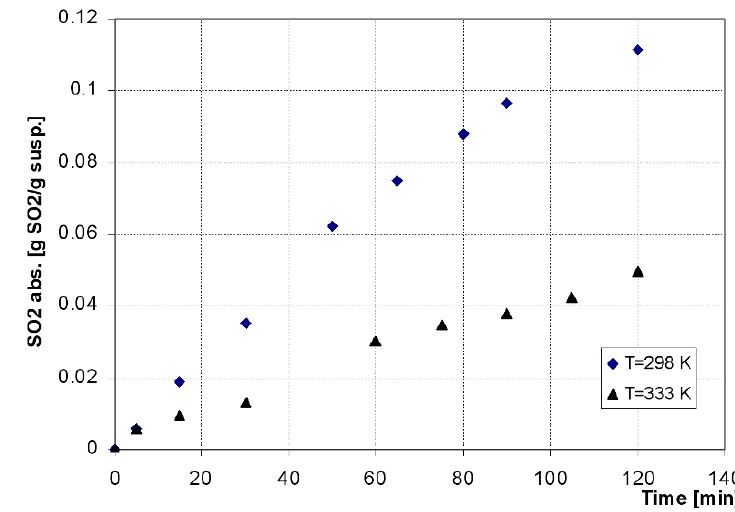
Figure 8. Kinetic data in sulfur dioxide absorption in limestone slurry with s/l=1/5 and dp=0.25 mm.